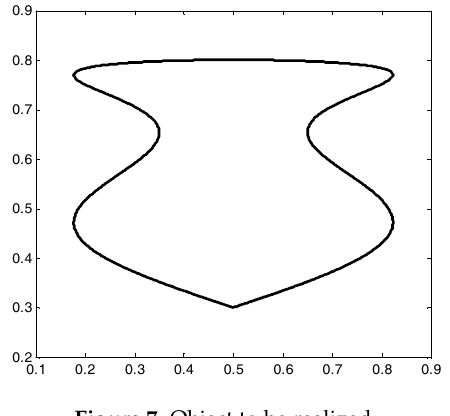
Figure 7. Object to be realized.